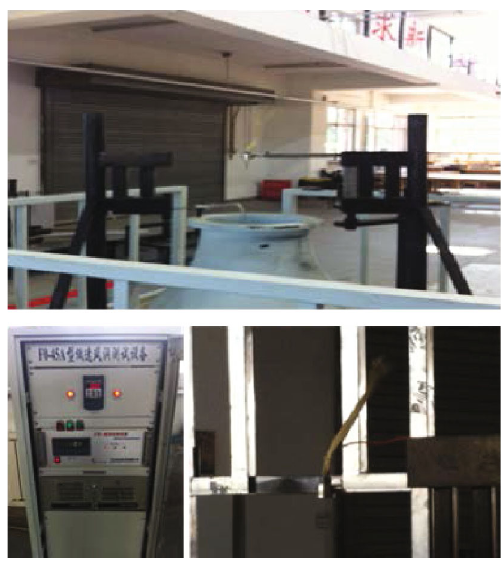
Figure 28: Experimental site.